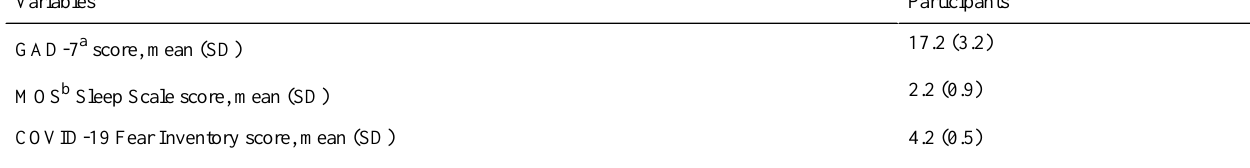
Table 1. Descriptive statistics of variables included in study (N=406).